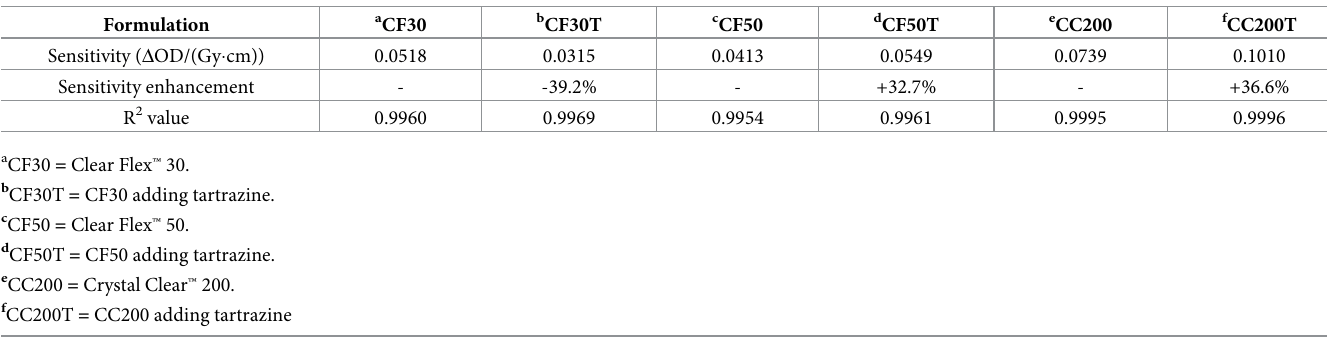
Table 4. For optical density measurements, the dose sensitivity was defined as the slope of the dose response curve. The sensitivity enhancements were defined as the ratio between the slopes of the different fabricated dosimeters.